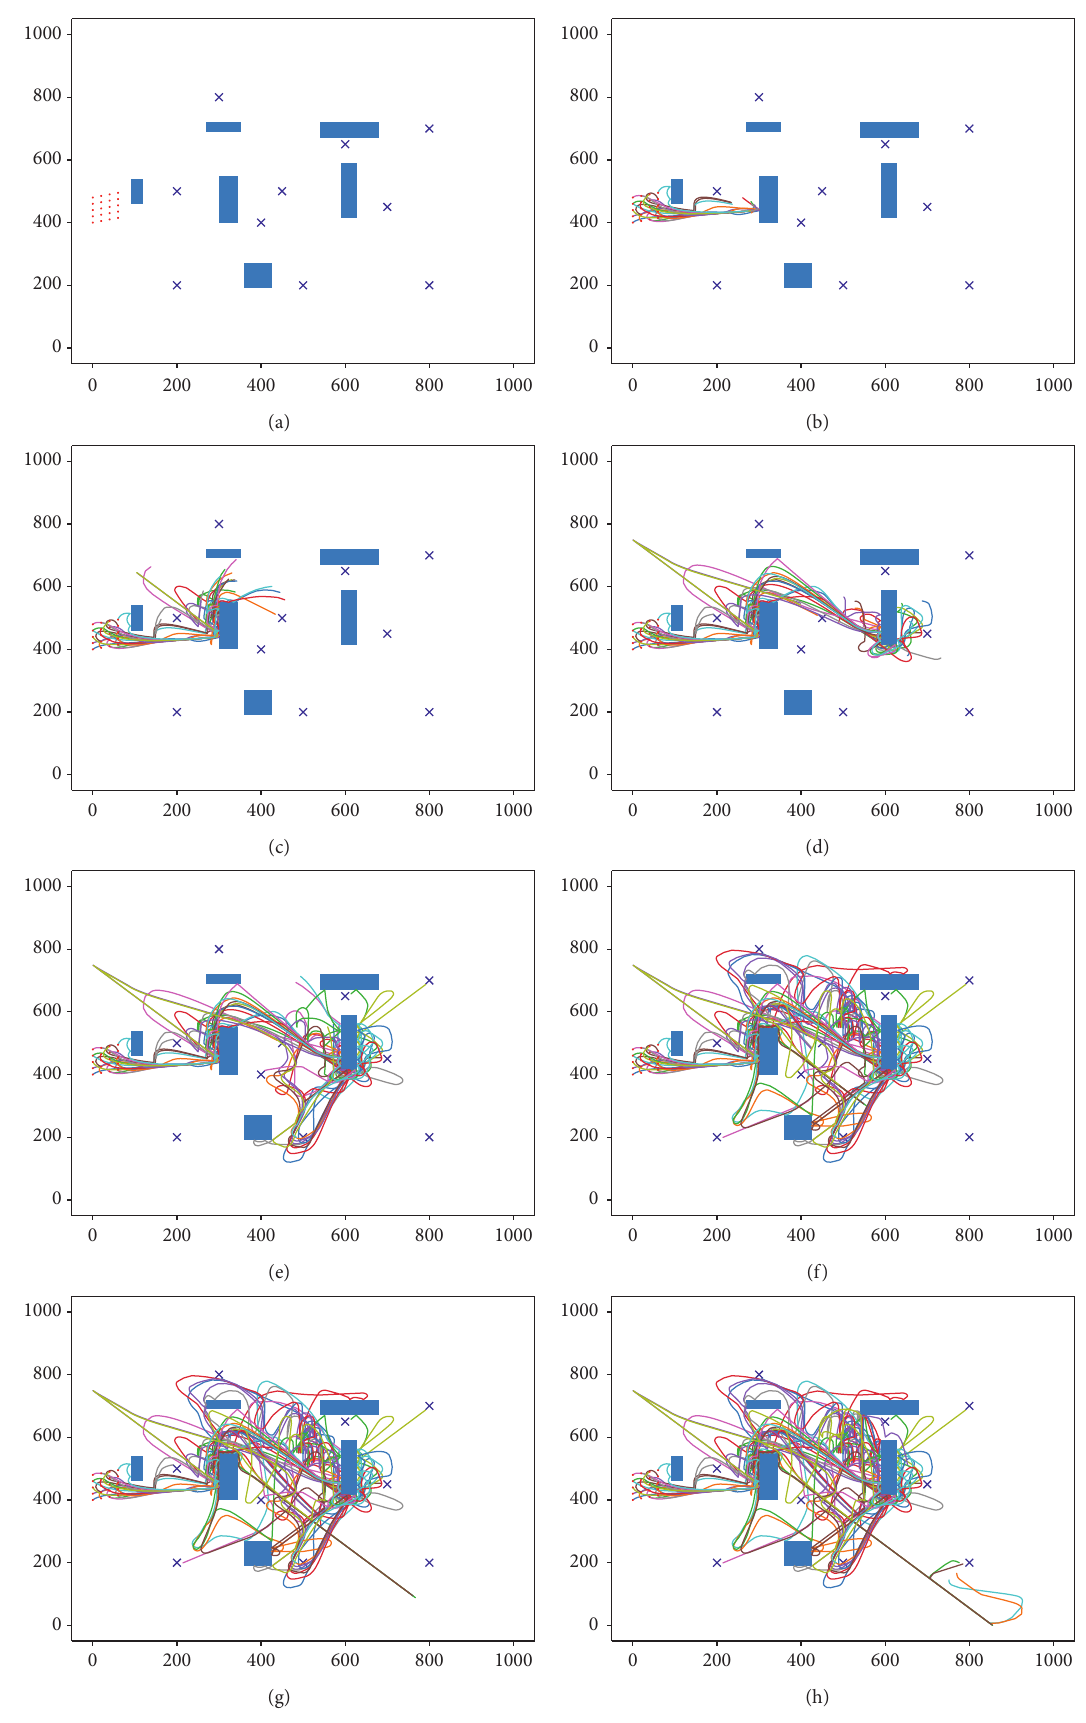
Figure 3: Multitarget search example of the proposed method. (a) t � 0. (b) t � 100. (c) t � 200. (d) t � 400. (e) t � 800. (f) t � 1200. (g) t � 1400. (h) t �